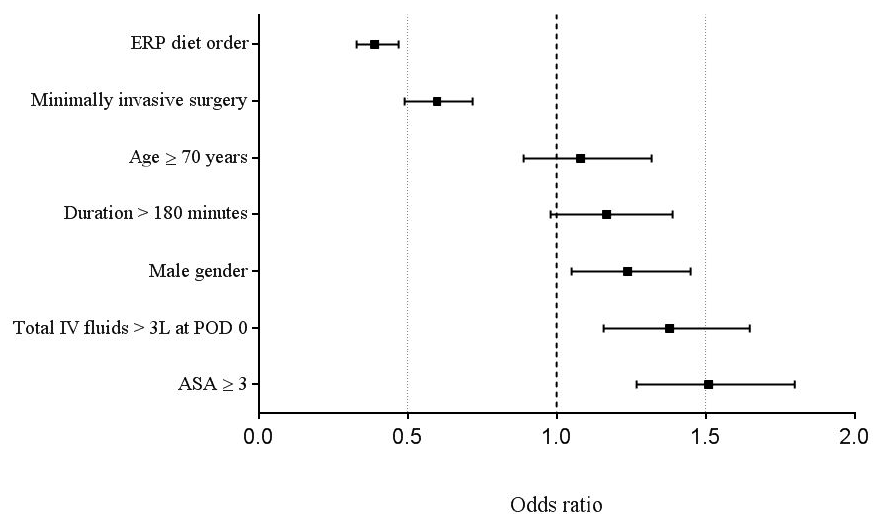
Figure 2. Multivariable analysis. Multivariable analysis of univariate demographic and surgical items ( p < 0.05) associated with POI. An Odds ratio of >1 indicates increased risk of POI. ASA—American Society of Anaesthesiologists, ERP—enhanced recovery pathway, IV—intravenous, POI—postoperative ileus. Odds ratio, 95% Confidence Interval.